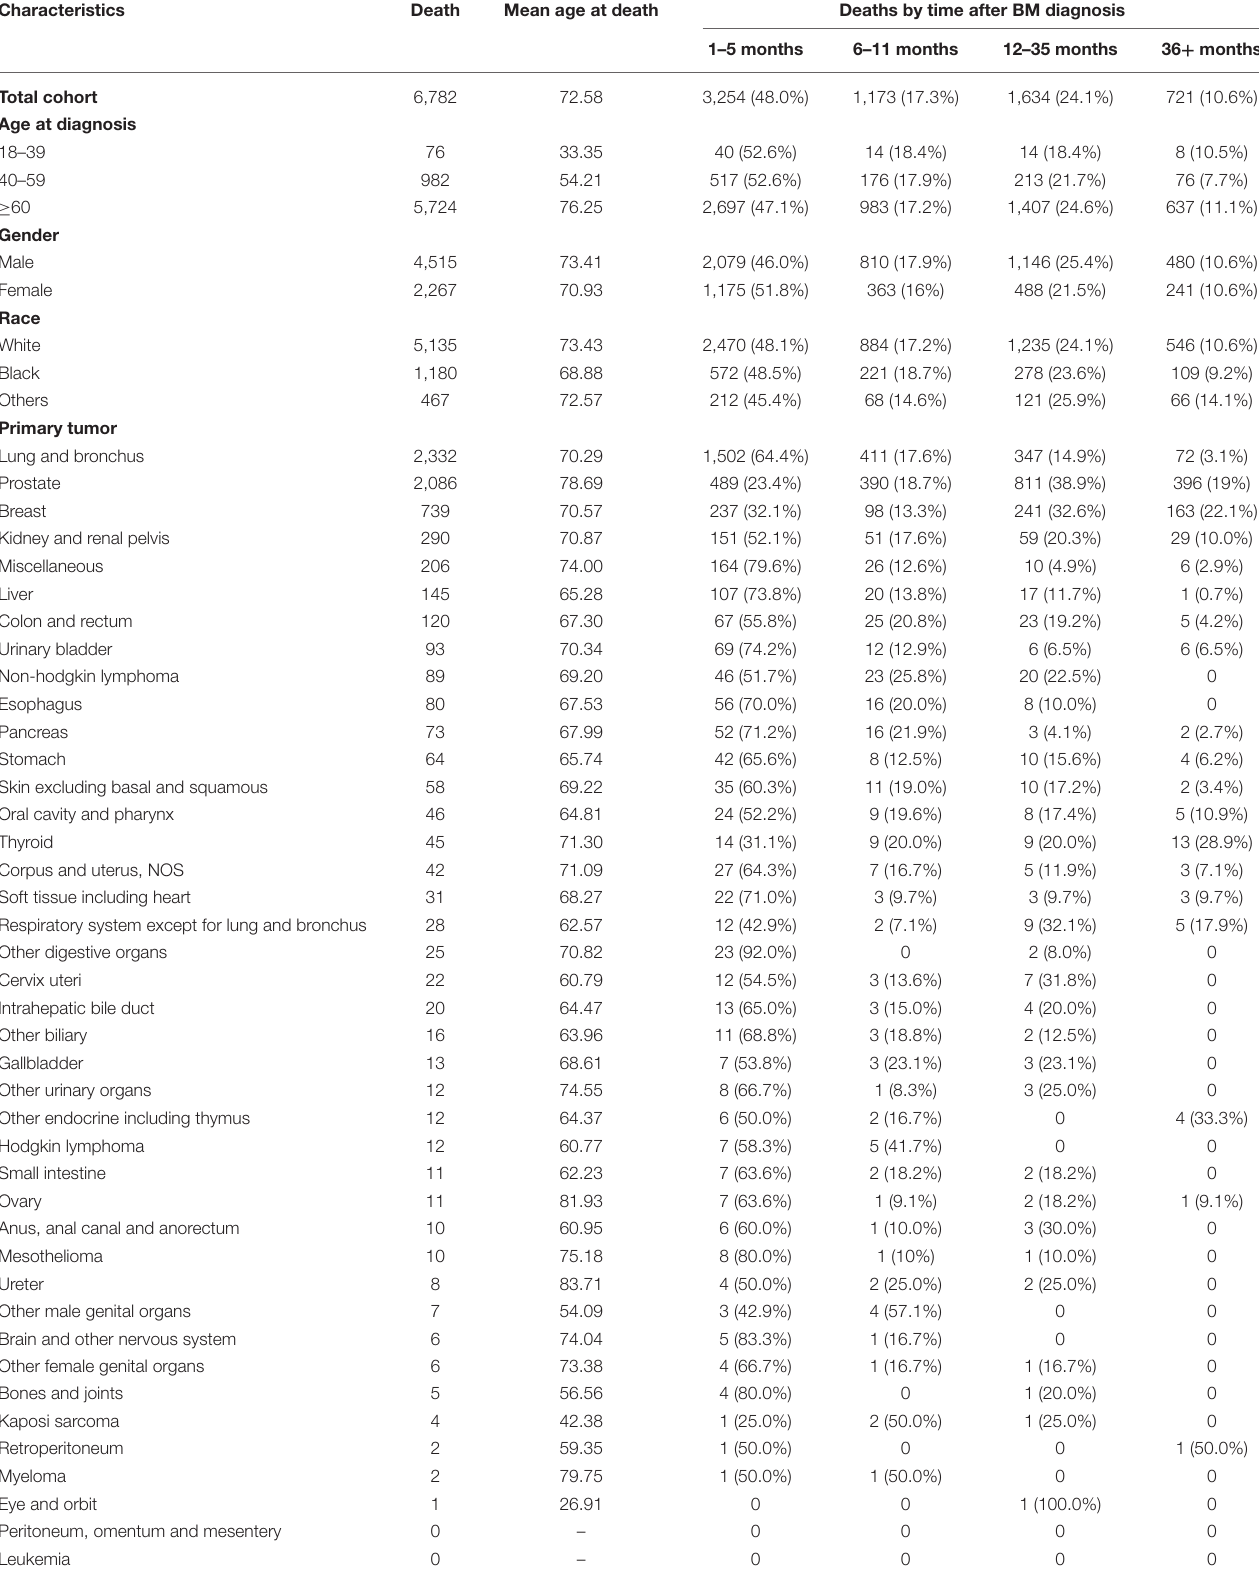
TABLE 2 | Baseline characteristics of cancer patients with bone metastasis who died of non-cancer causes and of those who died according to the time of death after initial diagnosis.